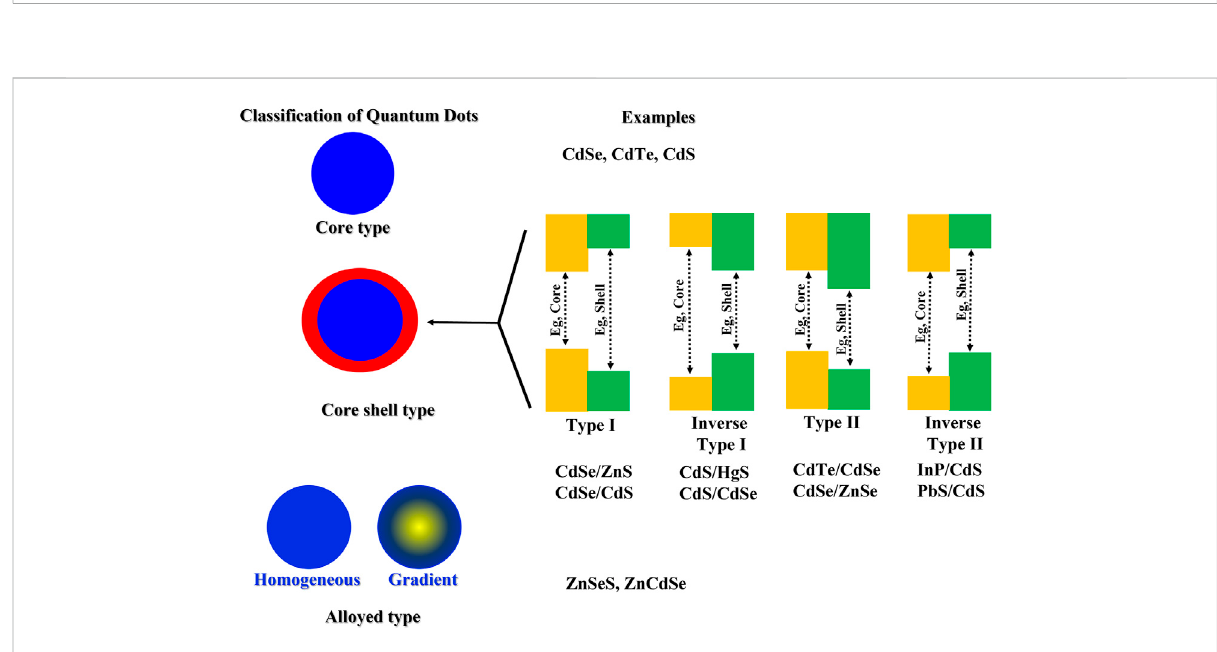
FIGURE 3 Classi fi cation of quantum dots with few examples of each